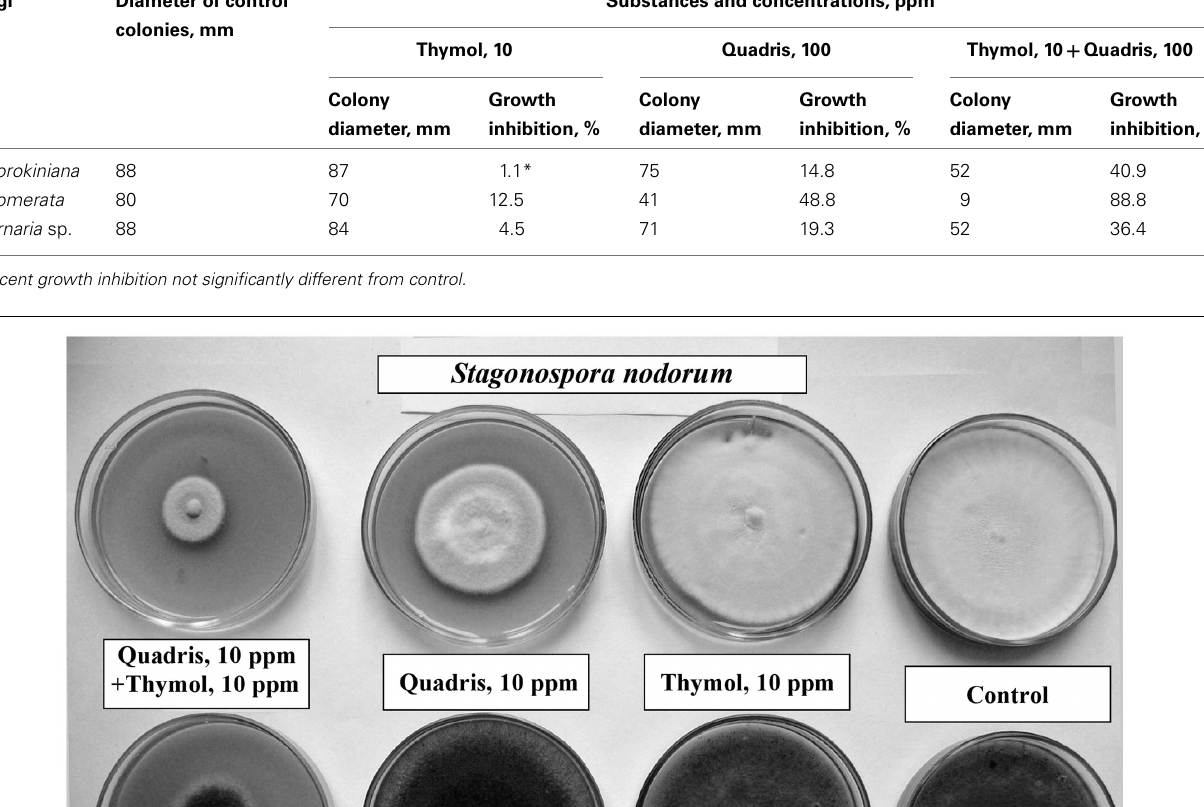
Table 1 | Fungicidal effect of thymol, Quadris, and their combination toward three plant pathogens at day 14 of in vitro testing. Fungi